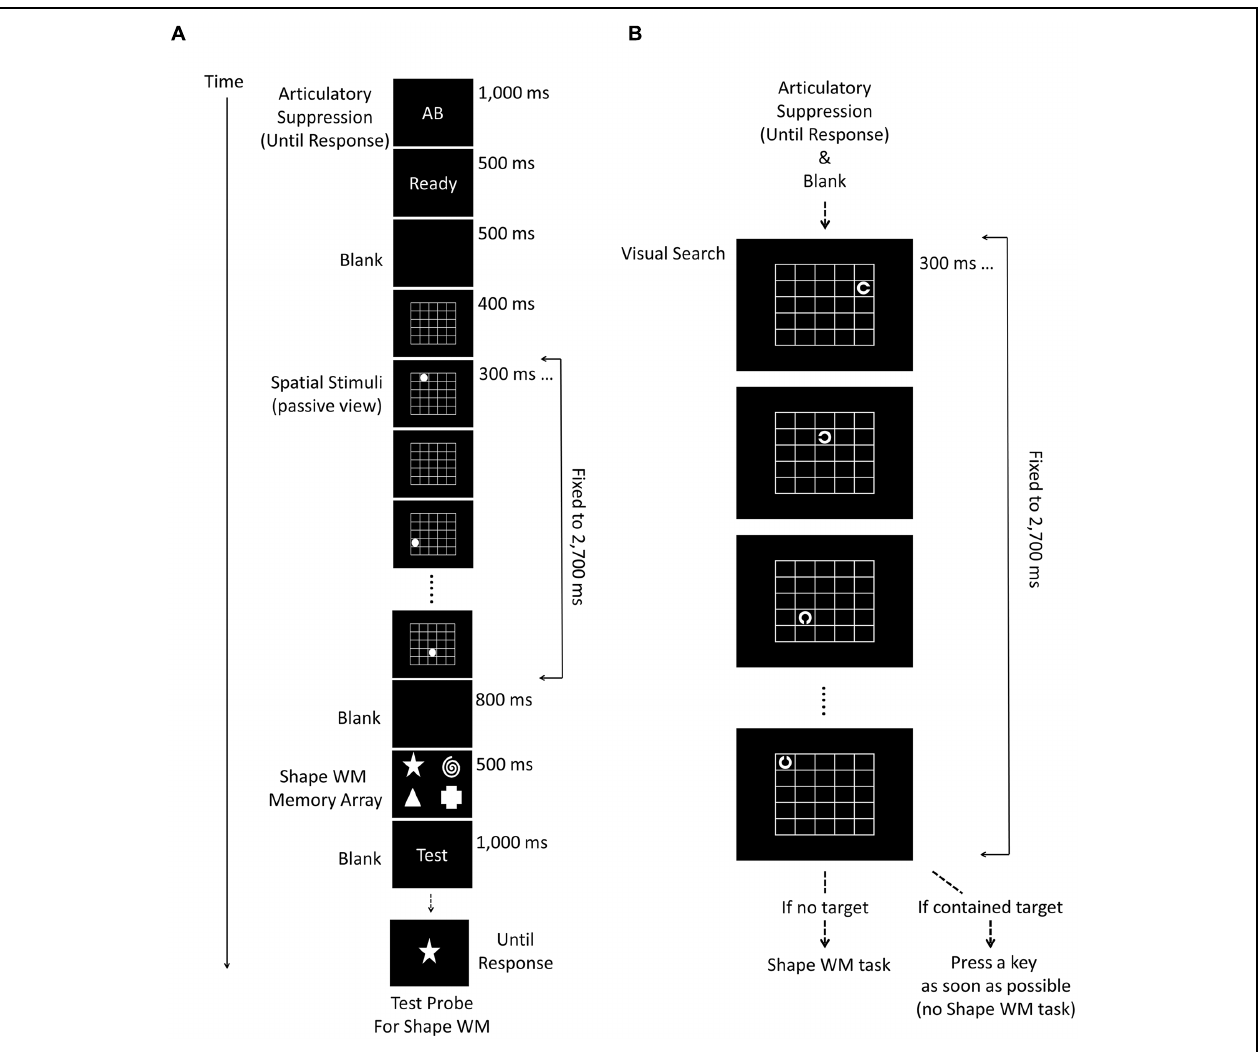
FIGURE 6 | Schematic diagrams of the experimental procedure used in additional preliminary experiments explained in Section “General Discussion.” The experiment that examined whether perceptual masking caused the interference effect is shown in (A) , and the experiment that examined attentional processes in (B) (see General Discussion for